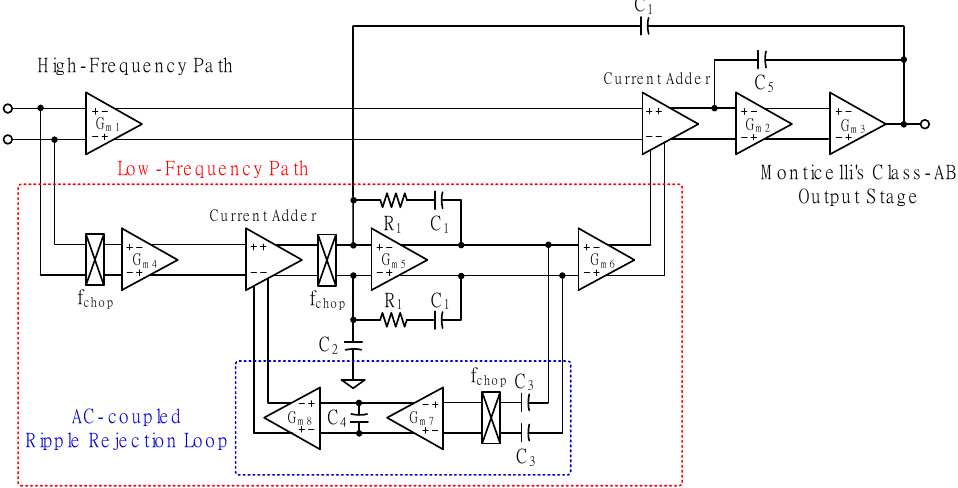
Figure 5. Block diagram of the chopper-stabilized, multi-path operational amplifier with an AC- coupled